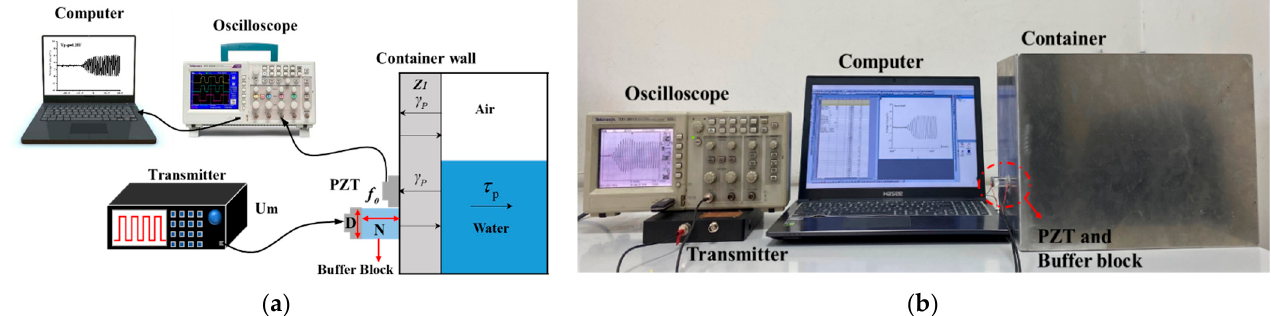
f = Natural f = Natural